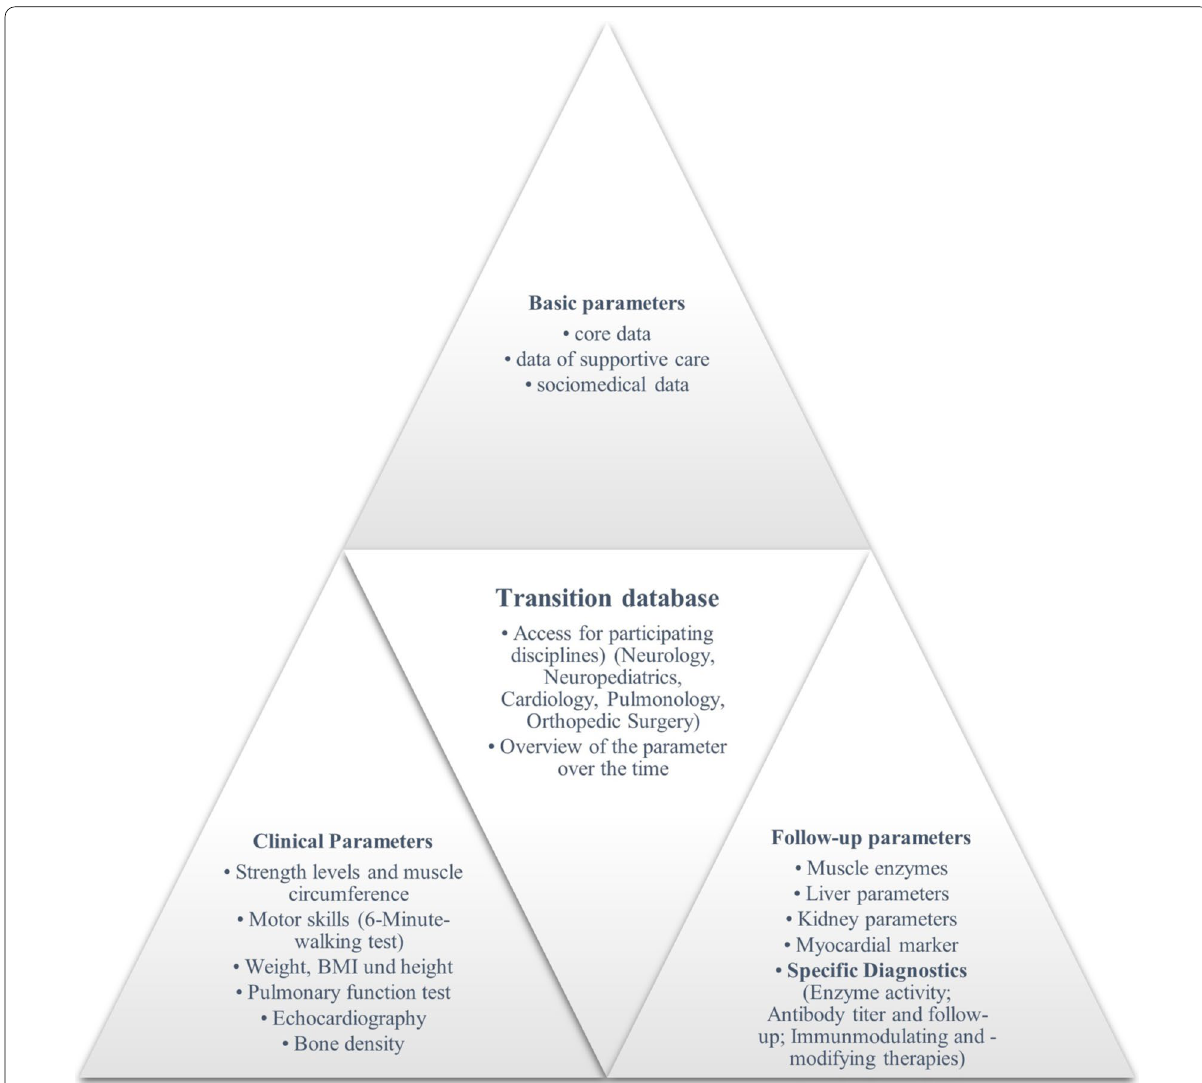
Fig. 2 Representation of the parameters that are included in the transition database and are made available across disciplines and clinics as well as over time. The parameters are divided into the groups basic parameters, clinical parameters and follow‑up parameters